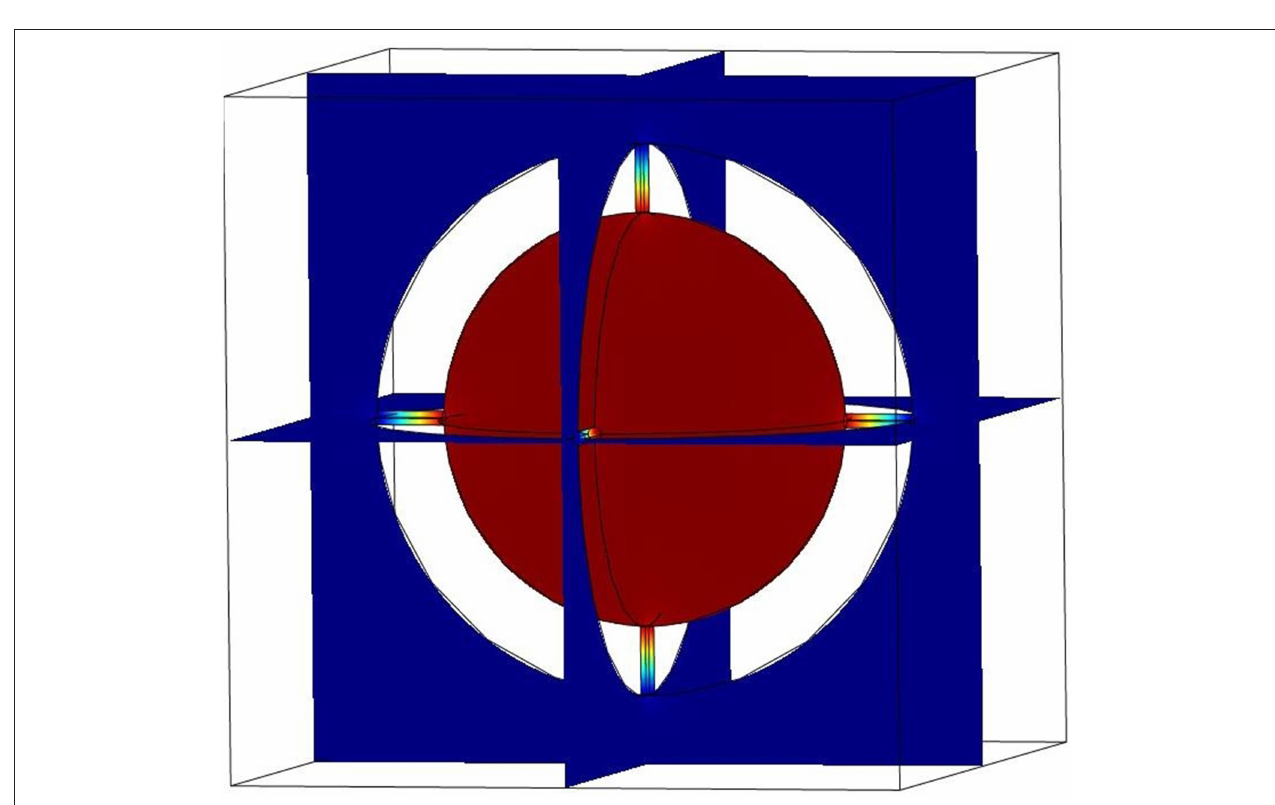
FIGURE 8 | The eigenfunction corresponding to the eigenfrequency ω ∗ 1 frequency is well approximated by the spring mass discrete model which provides us with the frequency estimate ω 1